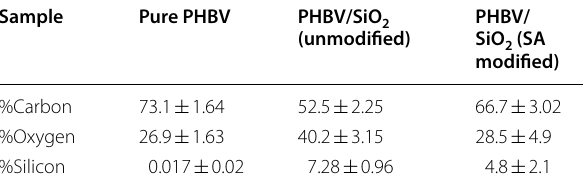
Table 1 Relative change in carbon and oxygen content following SiO incorporation and SA modification 2